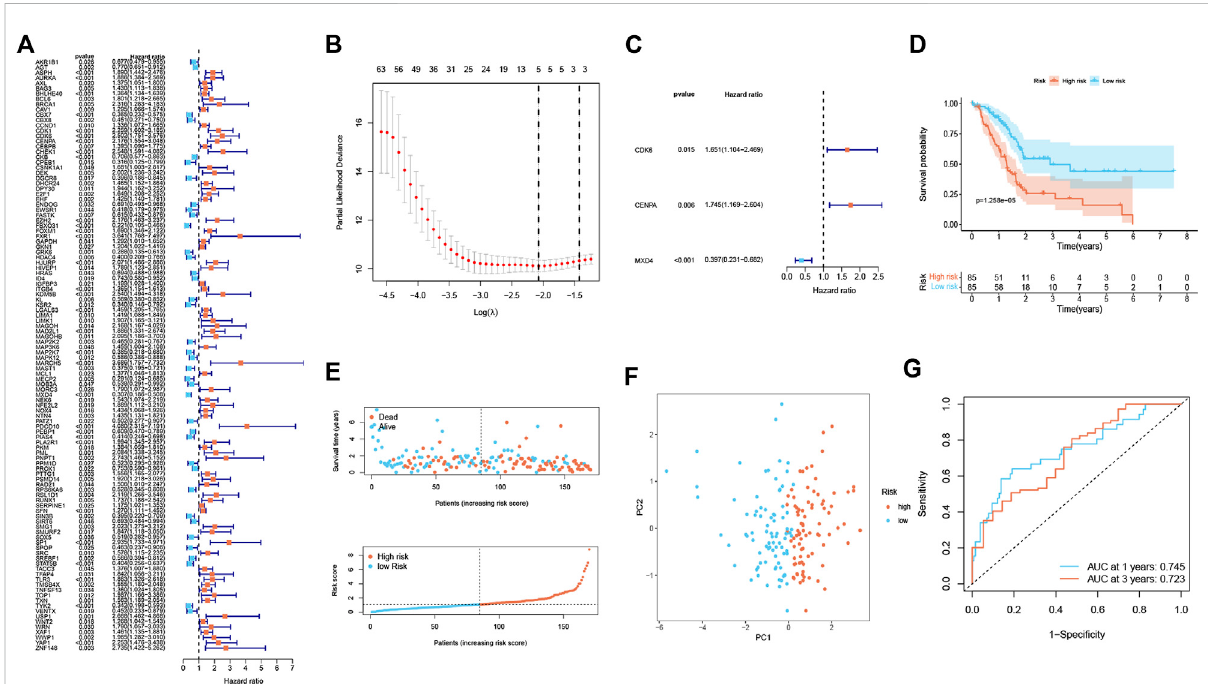
FIGURE 1 Establishment of a senescence-associated prognostic signature in the training cohort ( n = 170). (A) The prognostic SAGs were selected by univariateCoxregressionanalysis. (B) 10-fold cross-validation intheLASSO signature. (C) Thepresentationofthreeindependentprognosisgenesin multivariateCoxregressionanalysis. (D) Survivalanalysisbetweenlow-andhigh-risksubgroups. (E) Survivalstatusandriskscoredistribution. (F) PCA analysis displayed an obviousdifference intranscriptomes between two risk groups. (G) ROC curve.The accuracyof thesignature inpredicting 1- and 3-years survival of PDAC patients was